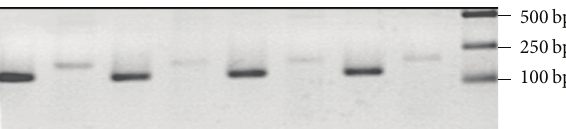
Figure 3: The expression of GLP-1R mRNA in the hypothalamus in four groups. From right to left: marker, C GLP-1R, C 𝛽 -actin, C + R GLP-1R, C + R 𝛽 -actin, D GLP-1R, D 𝛽 -actin, D + R GLP-1R, and D + R 𝛽 -actin. The expression of GLP-1 receptor of hypothalamus in